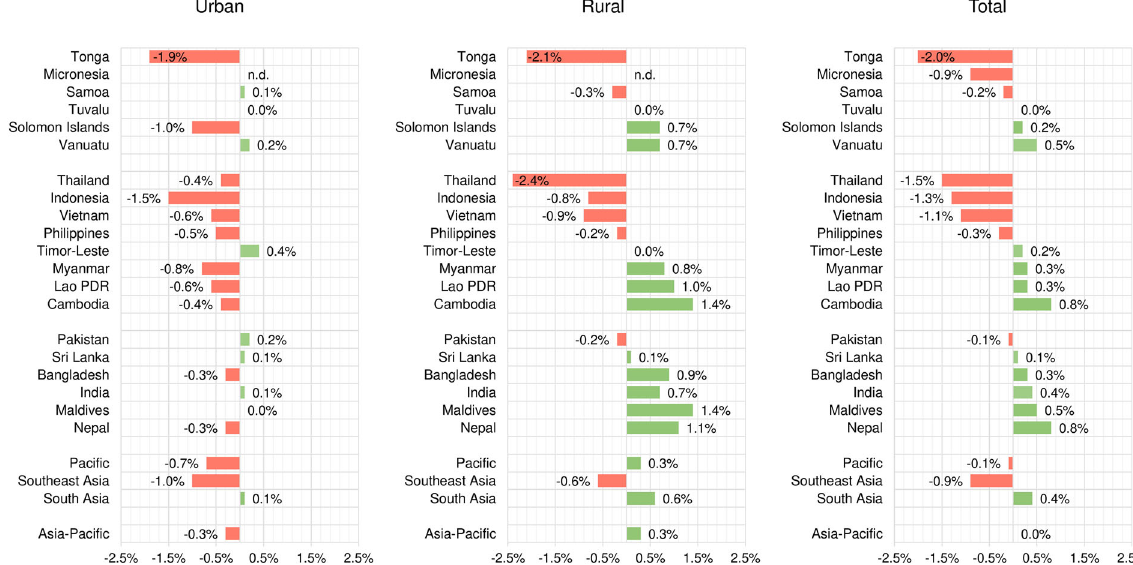
Fig. 7 Estimated annual change in proportion of population using self-supply as a main drinking water source in 2018. Changes are presented in terms of percentage points. Red bars indicate a reduction in the proportion of population using self-supply, while green bars indicate an increase in the proportion of population using of